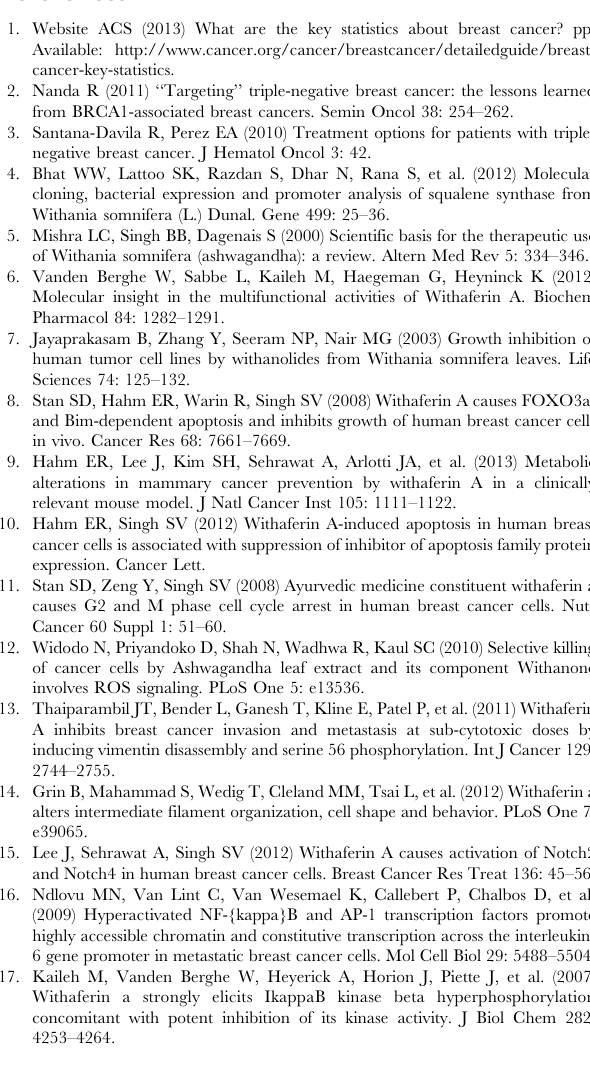
solvent in ‘Solv’ was matched with the amount of DMSO in the corresponding treatment. Invasive cells are indicated with white arrows; non-invasive cells are indicated in the middle panel. Figure S3 Concentration-dependent regulation of chro- matin modifying enzyme gene expression by WA in MDA-MB-231 and MCF-7 cells. The scatter plots of the mean 2 2 D Ct normalized expression values of each gene in the control samples (MDA-MB-231 DMSO, MCF-7 DMSO) versus the test samples (set-ups with WA) reveal the largest epigenetic plasticity of MDA-MB-231 cells exposed to the highest WA concentration (700 nM). The black line indicates fold change 2 2 DD Ct of 1. The dashed, gray lines indicate desired fold-change in gene expression threshold, here defined as 2. Table S1 A list of experimentally validated ChIP- sequencing data for genes regulated by E2F1 transcrip- tion factor in MCF-7 breast cancer cells.